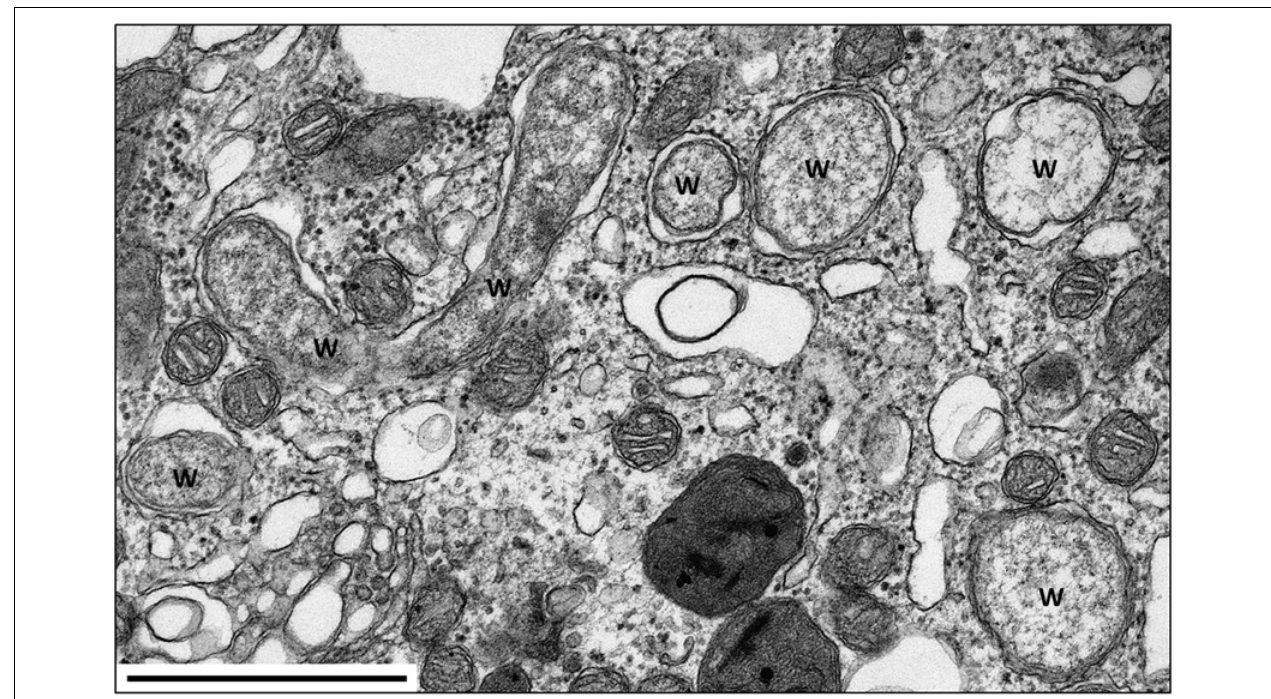
FIGURE 2 | TEM of Wolbachia in the nerve cord of A. vulgare . W = Wolbachia . Scale bar: 1 µ m. Picture credit: Maryline Raimond.